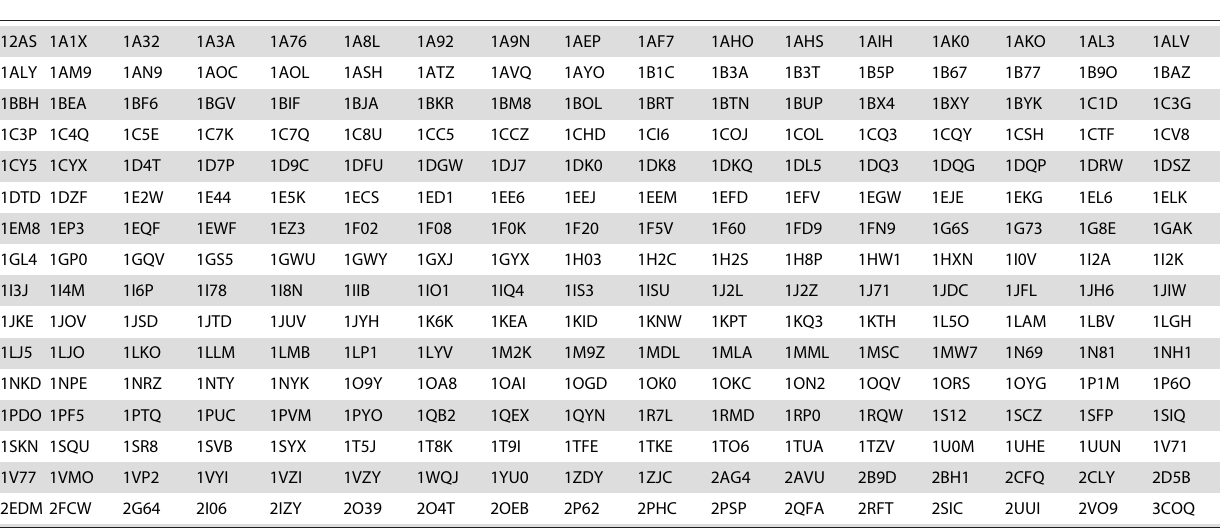
Table 1. PDB codes of the proteins in the